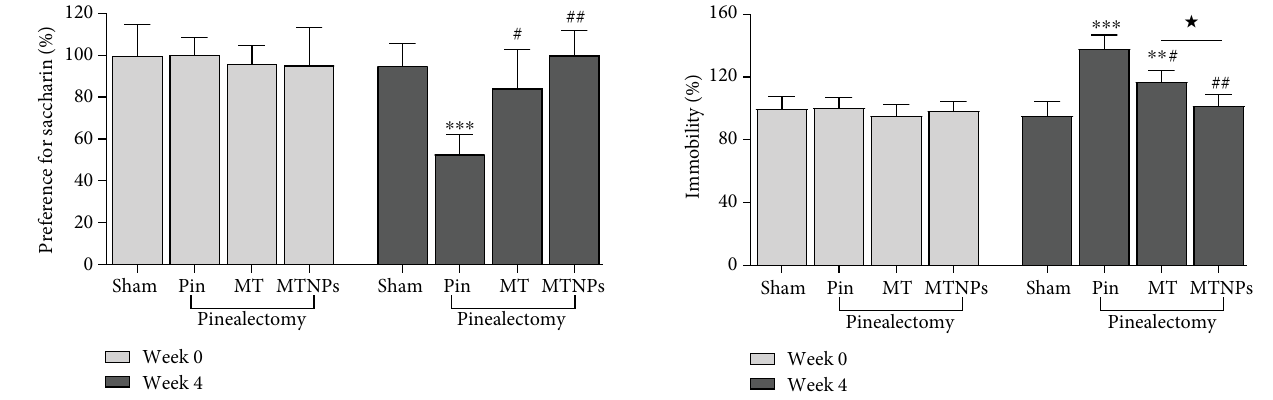
Figure 7: E ff ect of melatonin-loaded nanoparticles (MTNPs) on